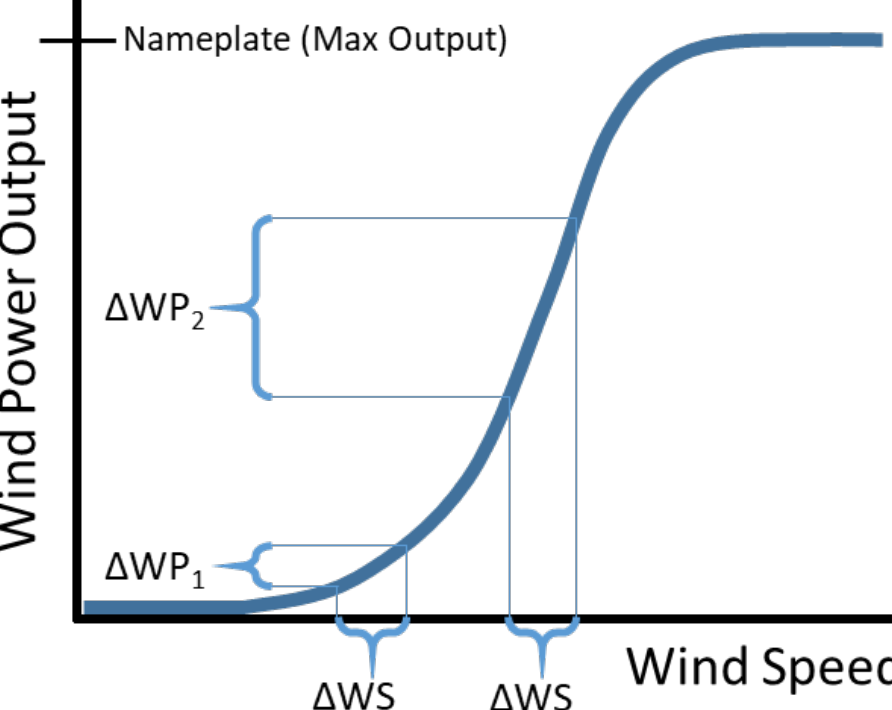
Figure 8. Relationship of Wind Power Output to Wind